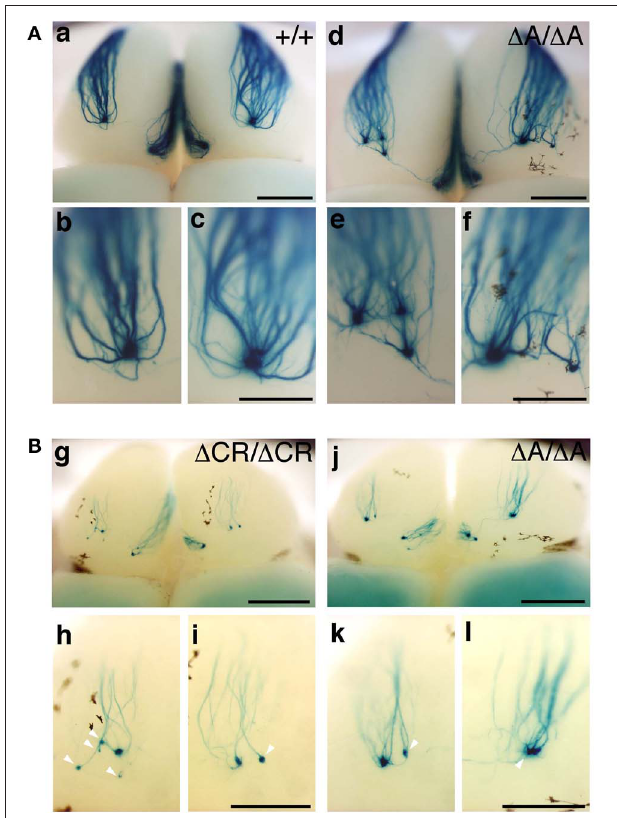
FIGURE 8 | M71 glomeruli in Pcdha (cid:2) A /(cid:2) A and Pcdha (cid:2) CR /(cid:2) CR mice. (A) X-gal-stained M71 glomeruli in WT (a–c) and Pcdha (cid:2) A /(cid:2) A (d–f) mice at P30. Multiple small, extraneous glomeruli were seen. (B) M71 glomeruli in Pcdha (cid:2) CR /(cid:2) CR (g–i) and Pcdha (cid:2) A /(cid:2) A (j–l) mice at P7. The abnormalities found in Pcdha (cid:2) A /(cid:2) A ( (cid:2) A/ (cid:2) A ) mice were similar to those of Pcdha (cid:2) CR /(cid:2) CR ( (cid:2) CR/ (cid:2) CR ) mice through development (P7–P60). Unlike these mice, axonal coalescence of the Pcdha (cid:2)( 2–c2 )/(cid:2)( 2–c2 ) mice appeared normal at least for the M71 and MOR23 OSNs (see Figure 7 ). Scale bars, 1mm for panels (a) and (d), 500 μ m for panels (b, c, e, f, g, and j), and 250 μ m for panels (h, i, k, and